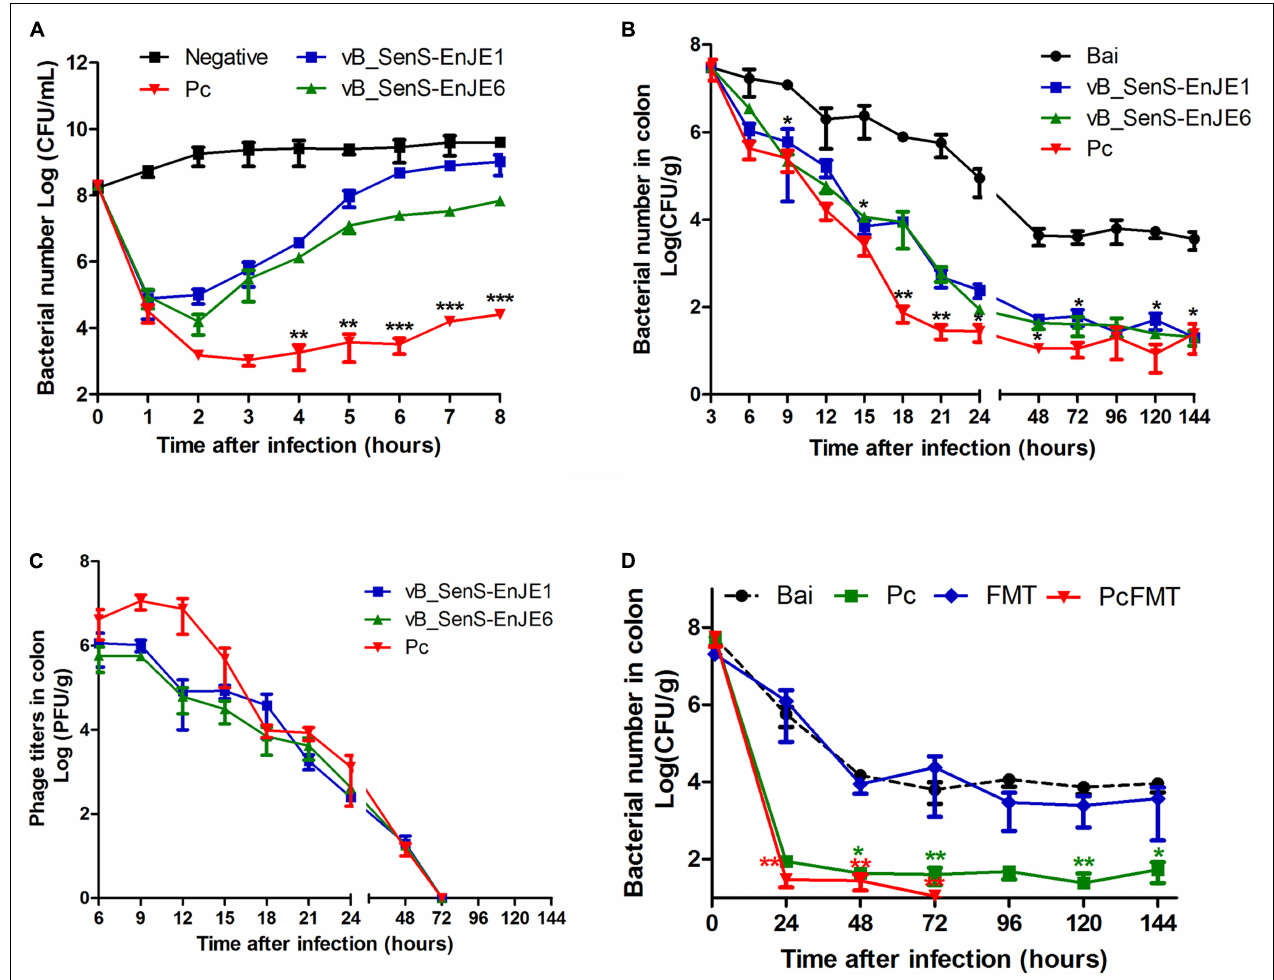
FIGURE 3 | Pc combined with FMT completely removed S. Typhimurium in vivo. (A) The antibacterial effect of single phage and Pc on S. Typhimurium in vitro at MOI = 0.1. Each independent experiment was repeated three times. The bacterial loads (B) and phage titres (C) in the colonic tissues of healthy, bacterially infected, single phage-treated and Pc-treated mice. (D) The bacterial loads in the colonic tissues of the bacterial-infected, single Pc-treated, and PcFMT-treated mice. Data are expressed as the means ± SEM, n = 6. * P < 0.05; ** P < 0.01; *** P <